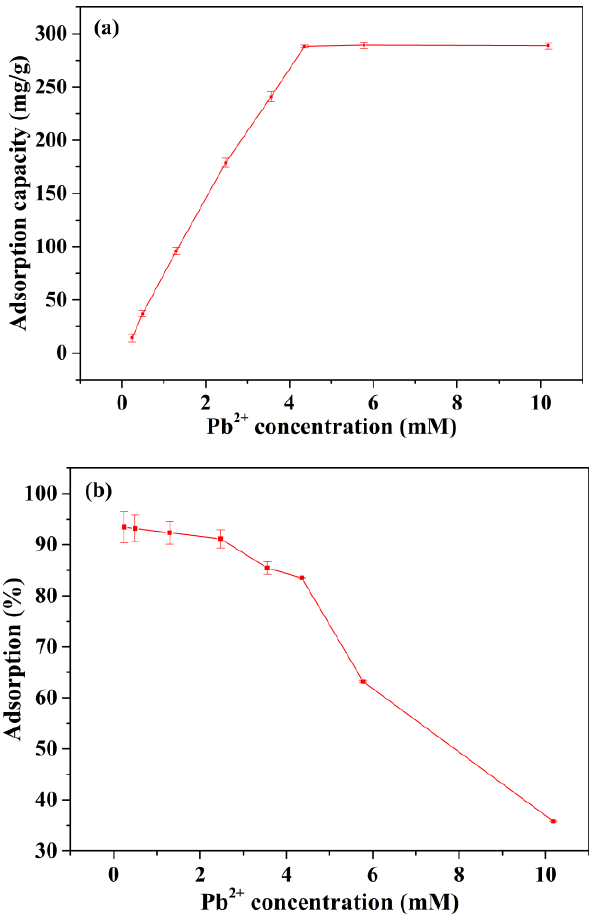
Figure 7. ( a ) Maximum adsorption capacity of Alg-Mel for Pb 2+ , ( b ) adsorption efficiency of the Alg-Mel in different concentration of Pb 2+ solution. (~100 mg of Alg-Mel was equilibrated with 40 mL of Pb 2+ solution at 25 °C and pH 5.0 for 6 h). Table 2. Comparison of the adsorption capacity of various sorbents towards Pb 2+.